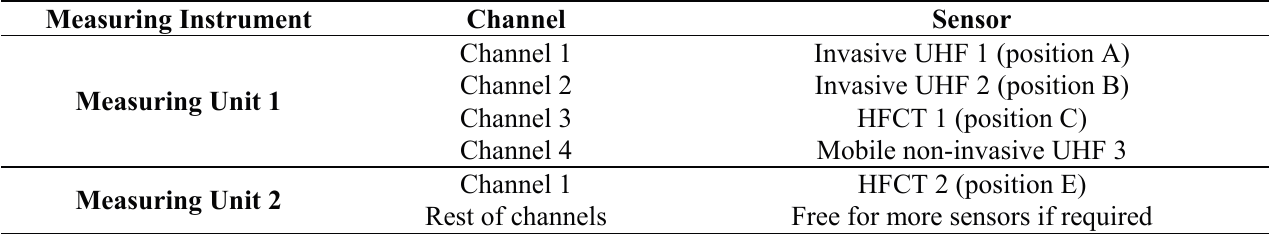
Table 3. Measuring instrument and channel assigned to each